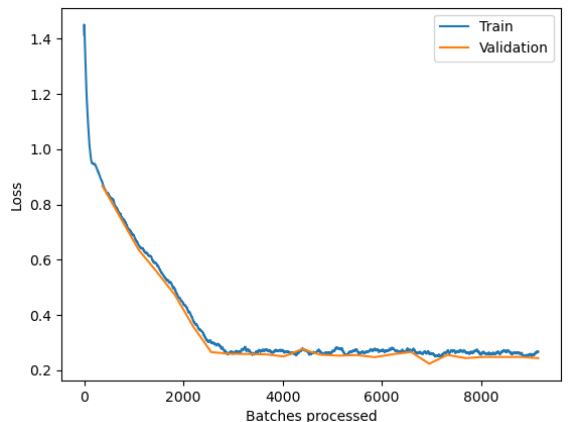
Figure 7. Training and validation loss during training. Training stopped after 25 epochs.